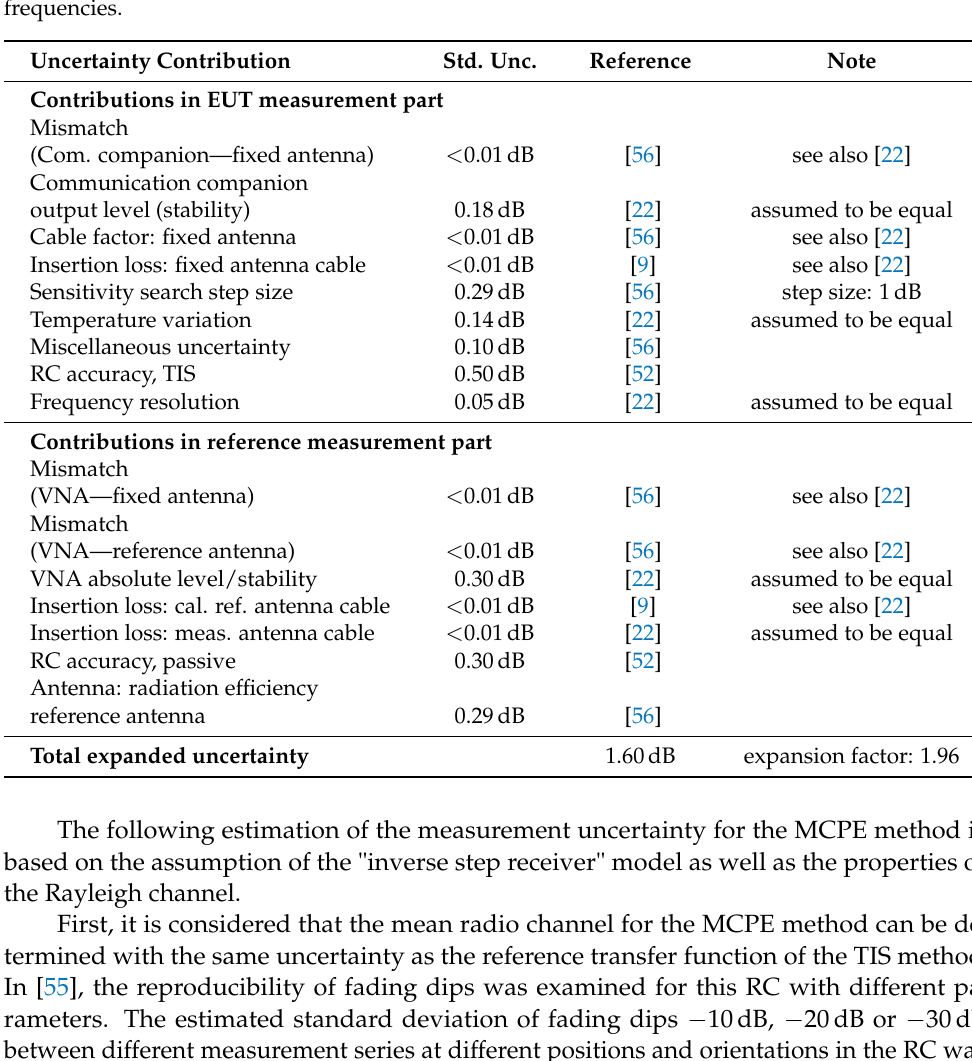
Table 7. Components for measurement uncertainty estimation for TIS measurements on single